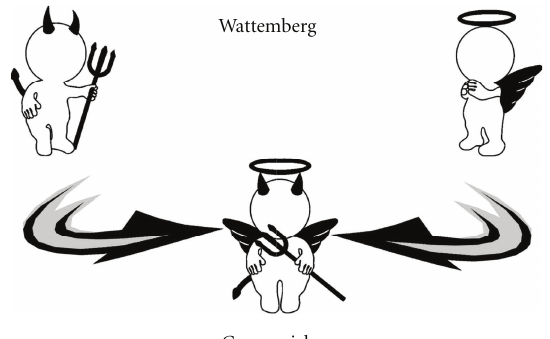
Figure 1: Allegoric representation of main di ff erence between clas- sic theory and data emerging from scientific literature. Since 1985 Wattenberg proposed chemoprevention strategies, including the ones that foresee the above mentioned manipulation of metabolic (according to the belief that they are classified as “bad-phase I” and “good-phase II”) enzyme activities, and Guengerich published a comprehensive review that suggested the “dual bioactivating and detoxifying nature” of each metabolic enzyme regardless of whether belongs to the phase I or II battery. The last theory (Guengerich) seems the correct ones, since the data emerging from scientific